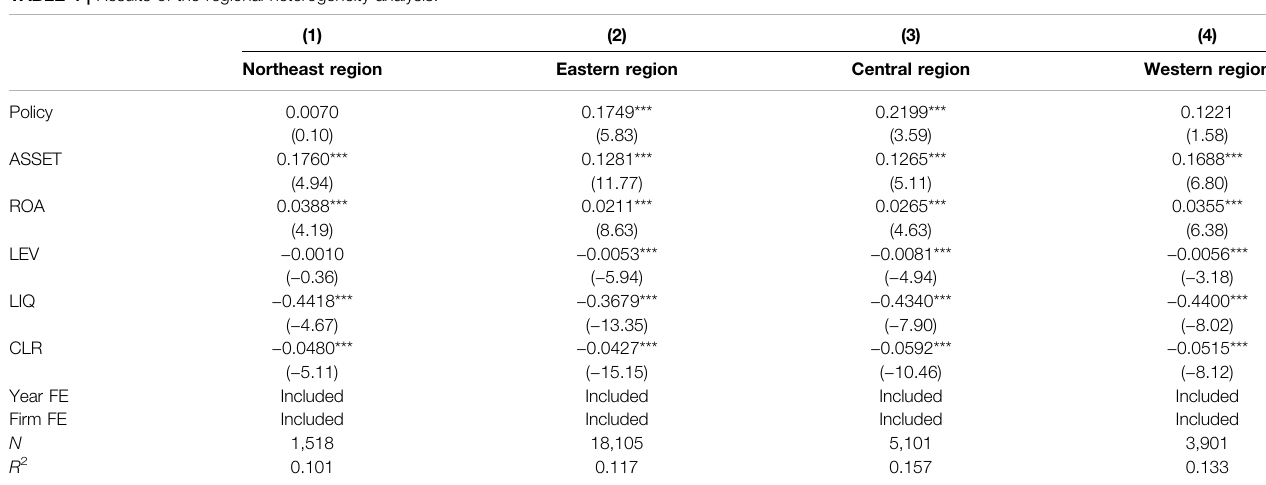
TABLE 4 | Results of the regional heterogeneity